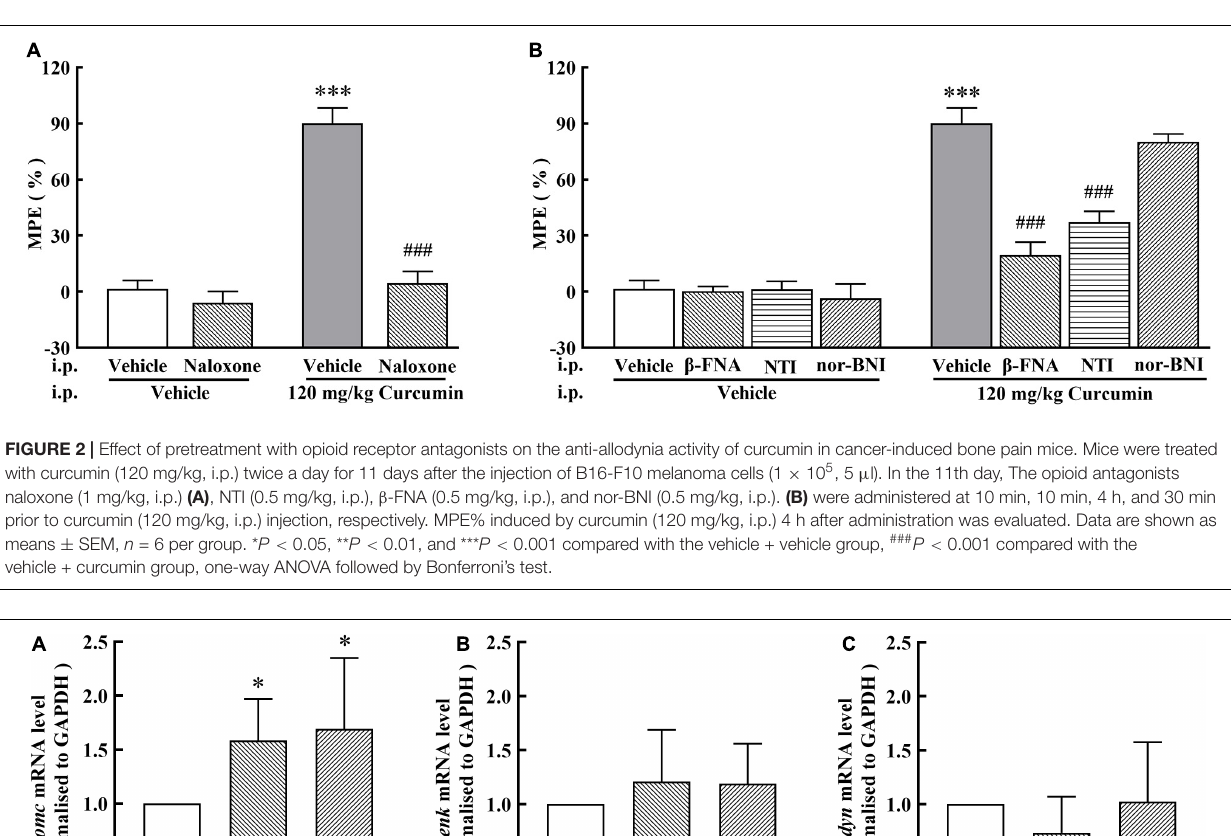
Figure 5 , the administration of β -endorphin antiserum,